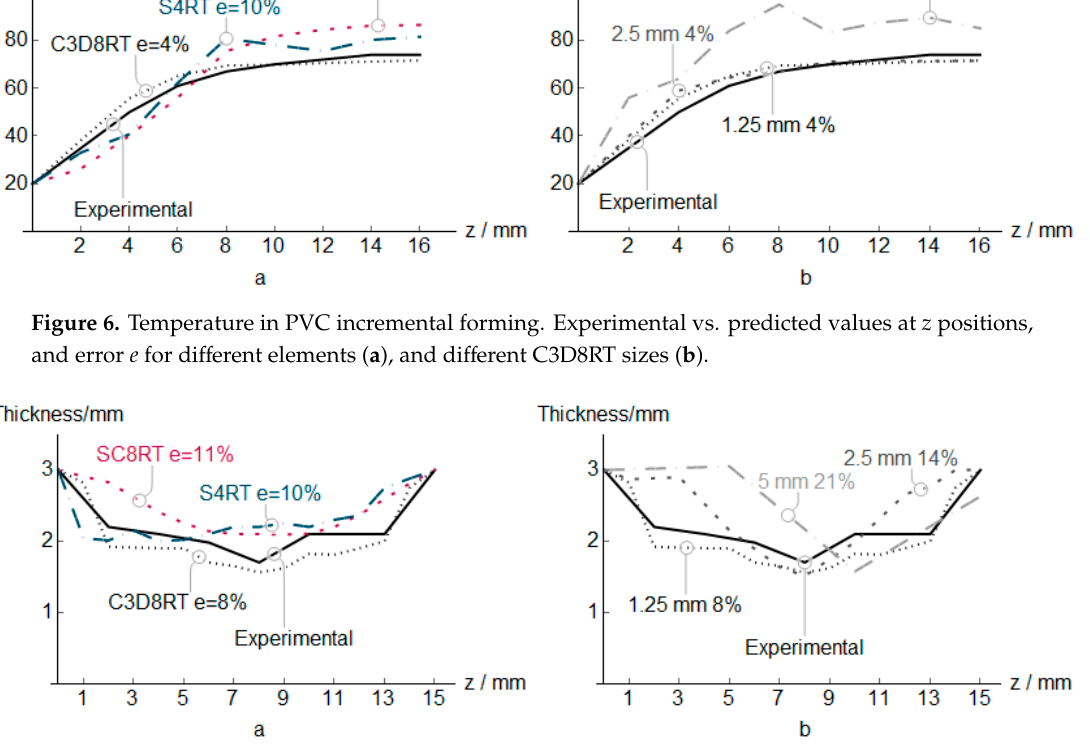
Figure 7. PVC sheet thickness estimation for different element types ( a ) and C3D8RT sizes ( b ).